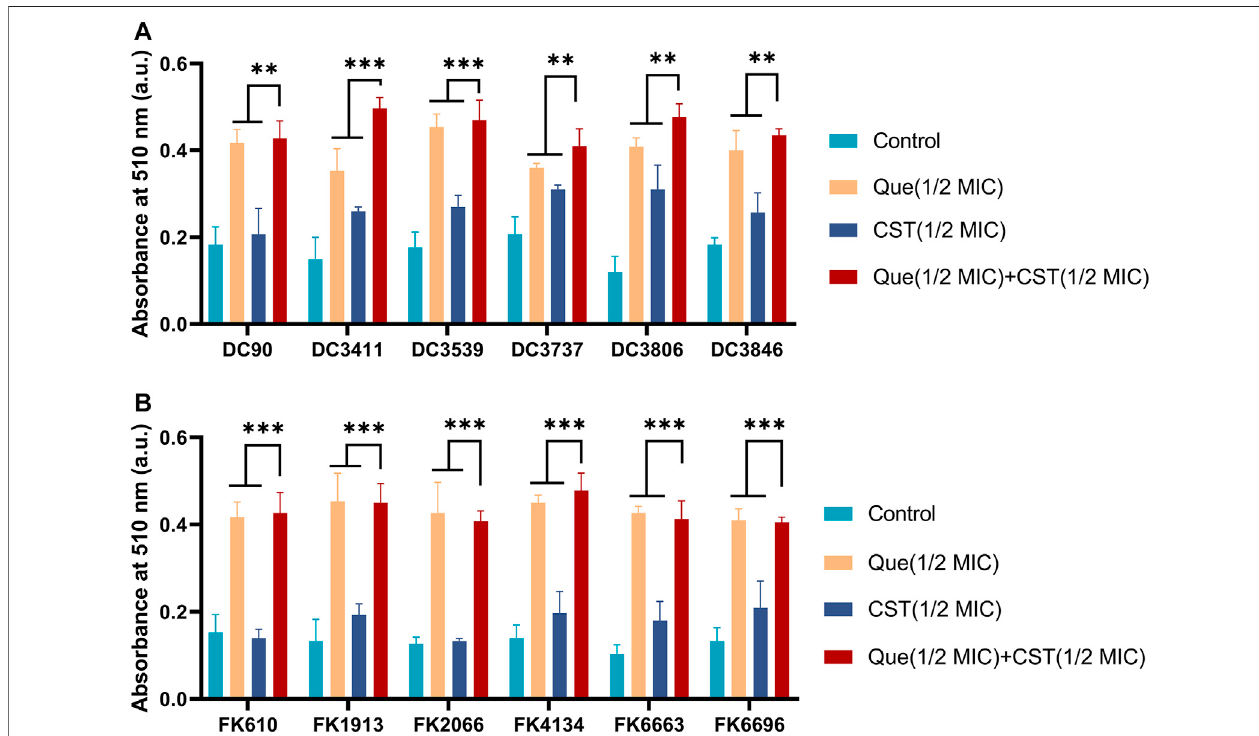
FIGURE 3 | Combination of quercetin and colistin contributes to the damage of bacterial cell membranes and the leakage of bacterial ALPs. The absorbance at 510 nmintegrityof E.coli (A) and K.pneumoniae (B) bydetectingALP.Thechartindicatesthatanincreaseforalkalinephosphataseinthemediumafterexposuretothe speci fi ed compound. The results are shown as the mean and standard deviation of three independent experiments. ns stands for not signi fi cant, * p < 0.05, ** p < 0.01, *** p < 0.001, determined by the Student ’ s t